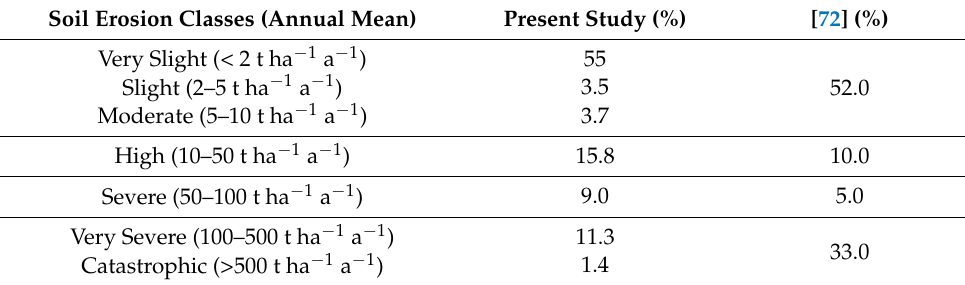
Table 4. Comparison of results by this study with results by [72]. Soil Erosion Classes (Annual